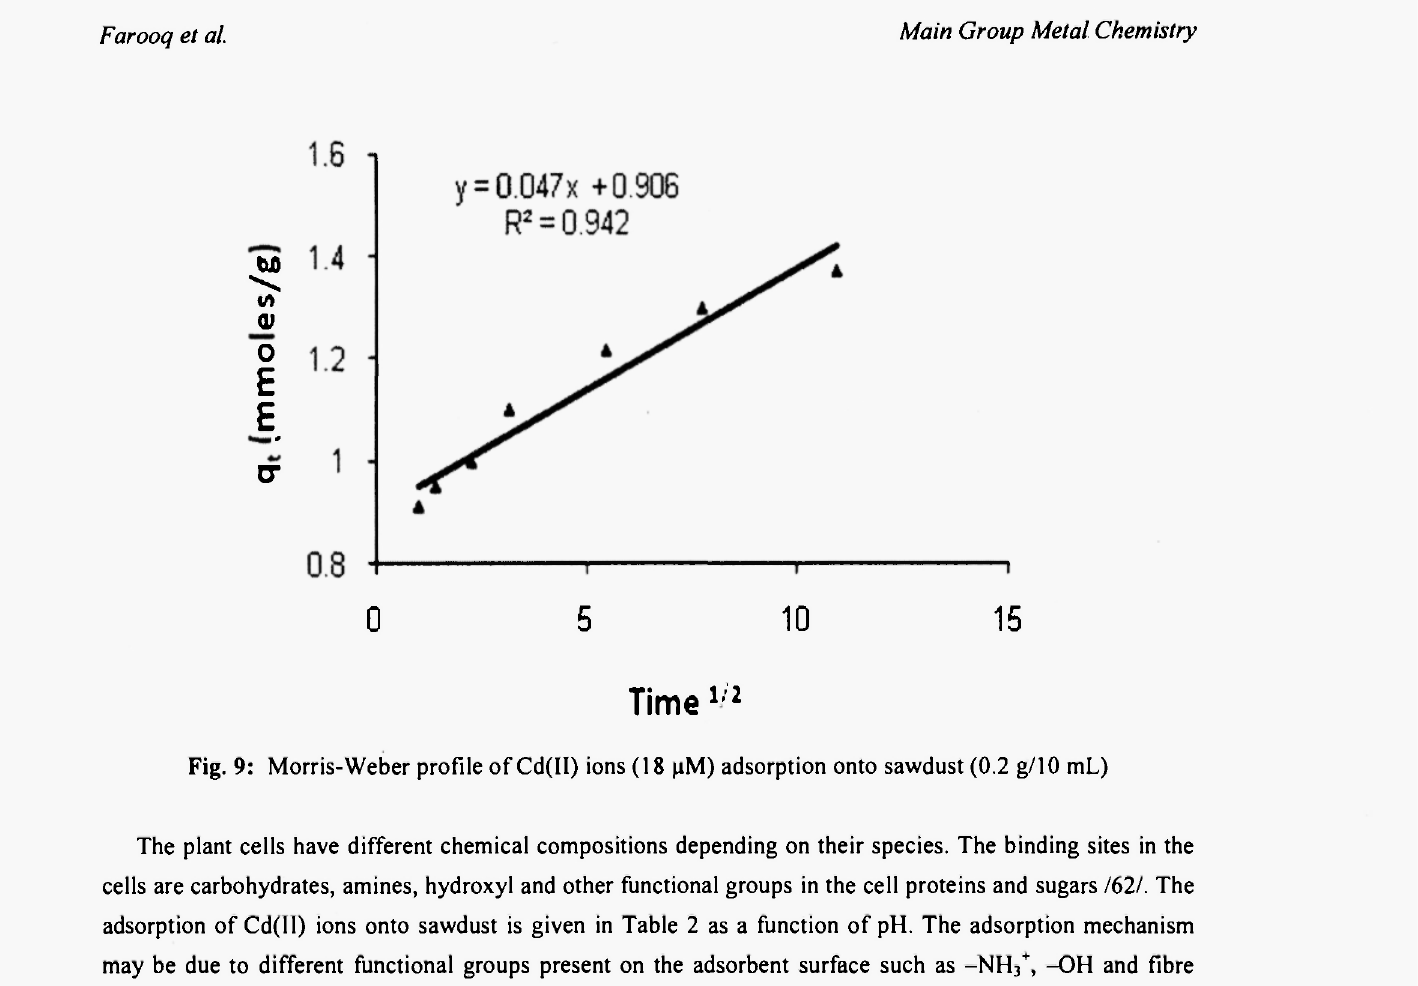
Fig. 9: Morris-Weber profile of Cd(II) ions (18 μΜ) adsorption onto sawdust (0.2 g/10 mL)